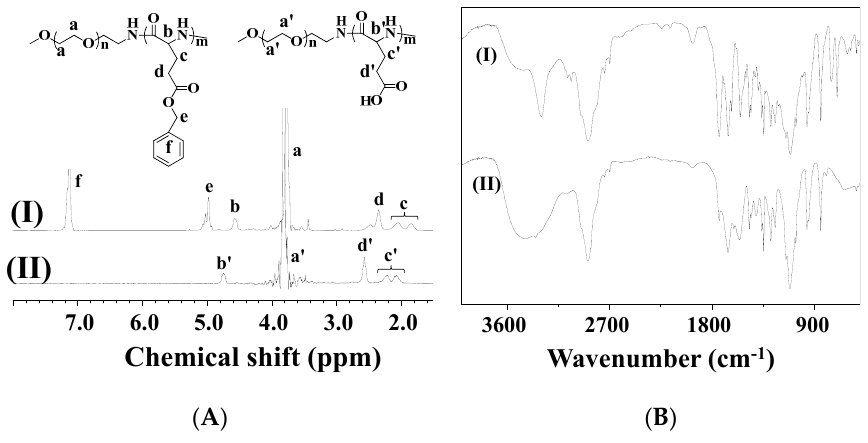
Figure 1. 1 H NMR ( A ) and FI-IR spectra ( B ) of mPEG- b -PBLG (I) and mPEG- b -PGA (II).